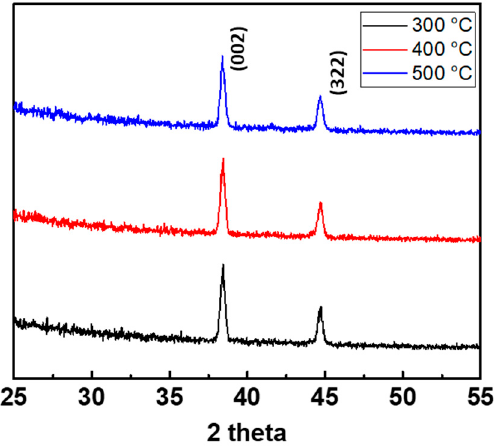
Figure 3. XRD profiles of the printed ZTO films at various annealing temperatures.